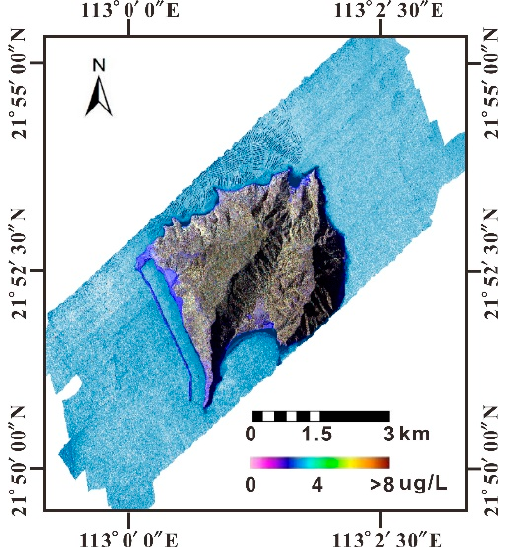
Figure 4. Distribution of Chl-a inversed by CASI data in the sea area around Dajin Island.